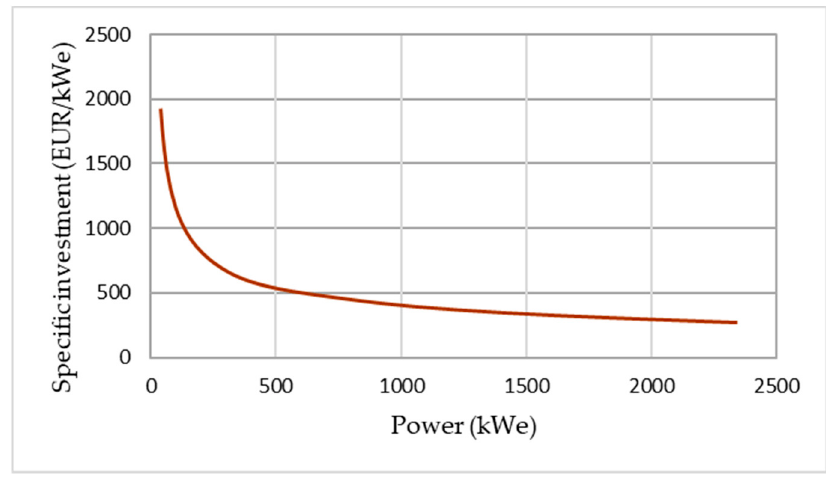
Figure 3. Costs of natural gas–fired CHP engines.